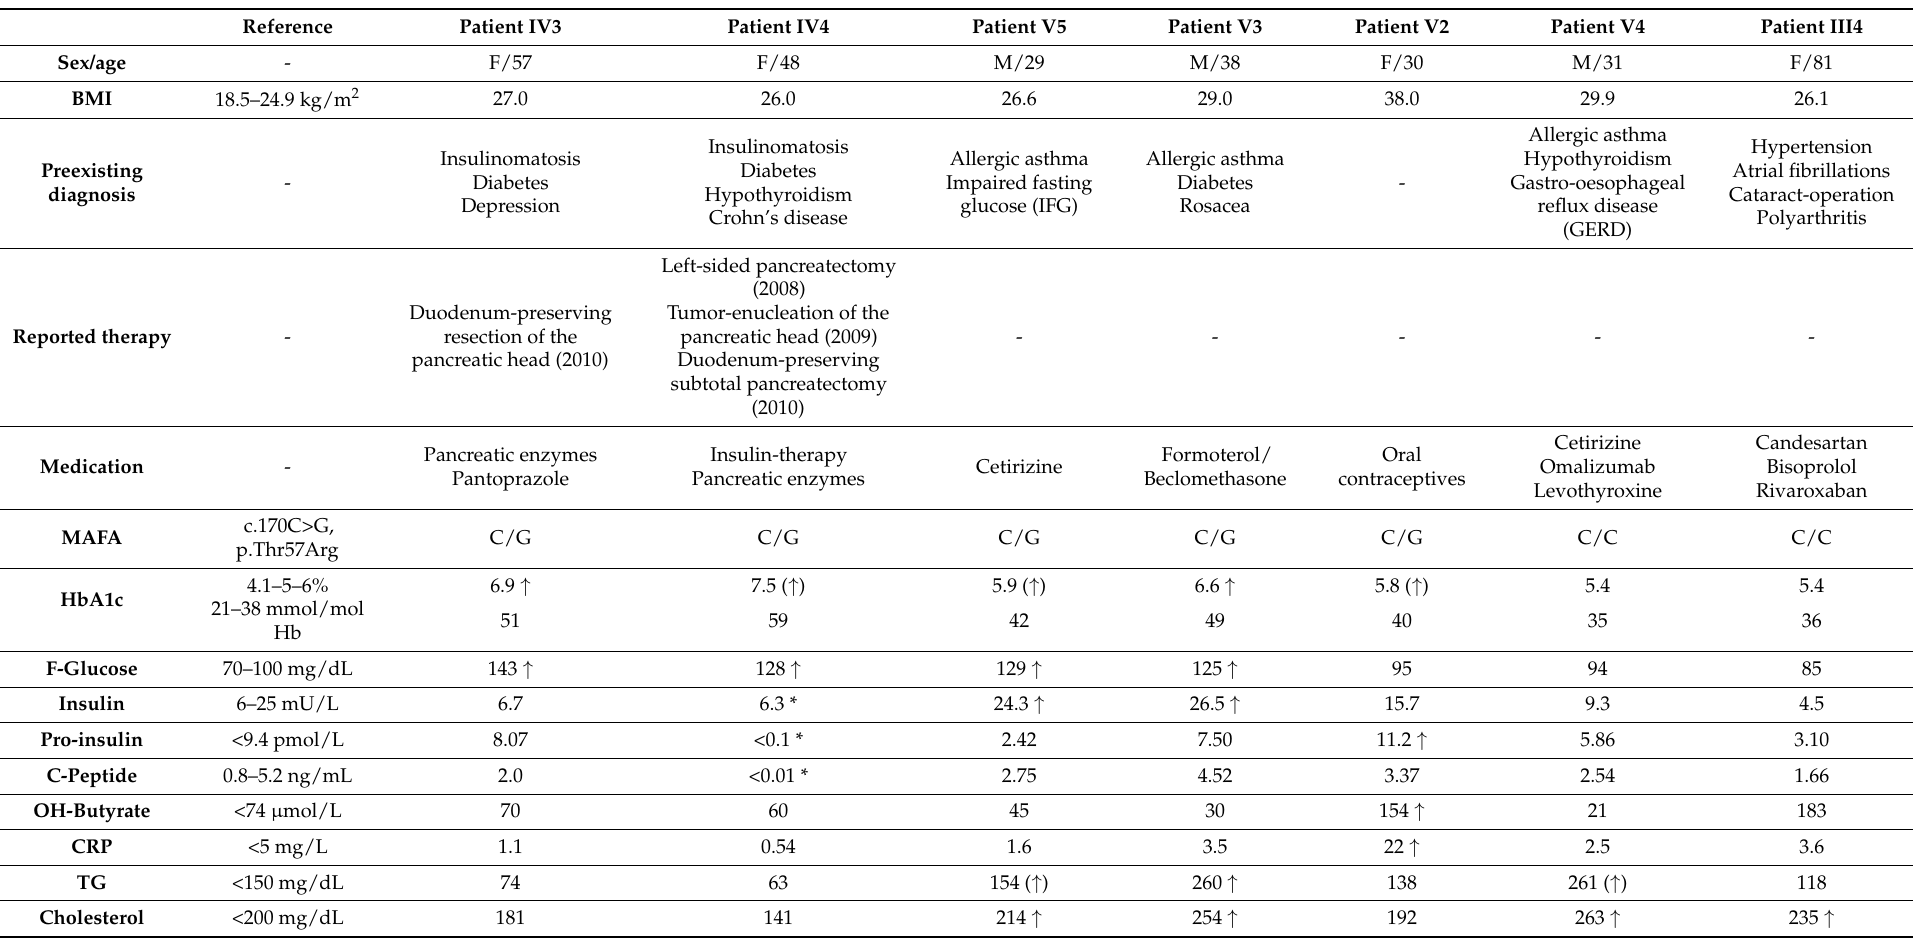
Table 2. Clinical characteristics and laboratory results of two patients with insulinomatosis (IV3 and IV4) and five relatives (V2, 3, 4, 5; III4). In family members III5, IV5, V6, and V7, the laboratory tests indicated in the table were also performed. Since there were no abnormalities in glucose metabolism and neither the MAFA nor the PROX1 variant was detected in the corresponding branch of the family, we have not presented the test results in this table.